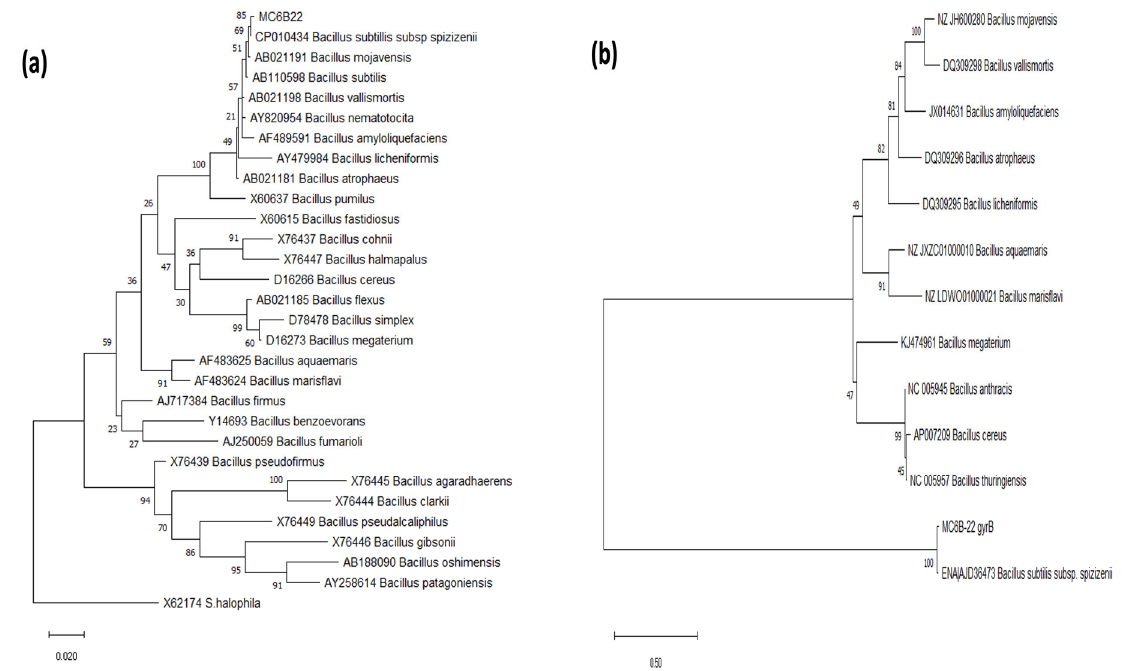
Figure 1. Maximum Likelihood Phylogenetic trees. Diagrams were obtained using 16S rRNA ( a ) and ( b ) Gyrase B Subunit gene sequences. The bootstrap consensus trees inferred from 1000 replicates were taken to represent the evolutionary history of the taxa analyzed. Branches corresponding to partitions reproduced in less than 50% bootstrap replicates are collapsed; the percentage of replicate trees is shown next to the branches.